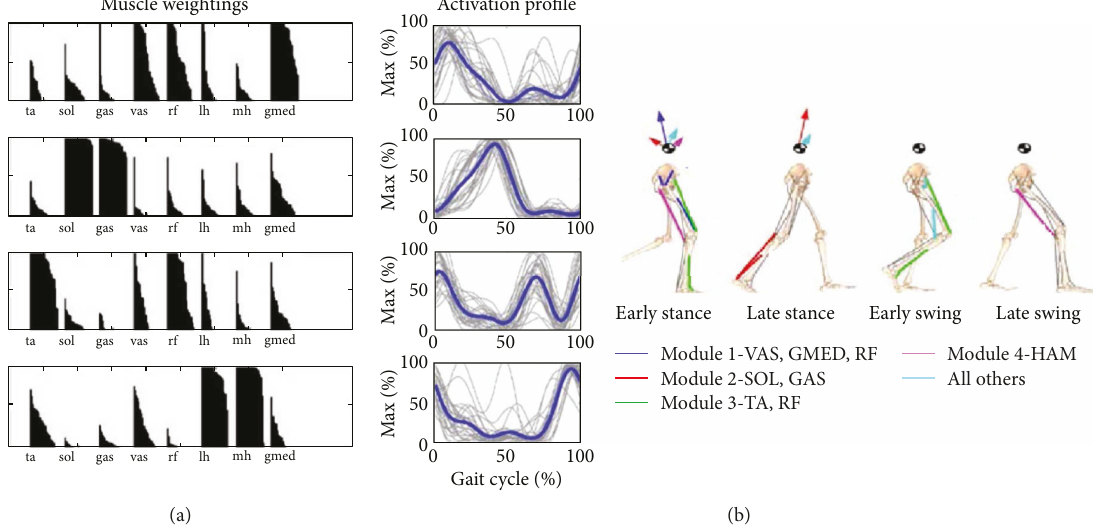
Figure 1: Image and caption modi fi ed from Clark et al. [14] and Neptune et al. [15]. (a) Muscle coactivation weightings from healthy individual walking at 1.2m/s determined from NNMF. (b) Activation pro fi les represent the timing of the module during the gait cycle. The thin lines were individuals from Clark et al. [14] with thicker lines representing the group average. Module contributions to walking are demonstrated on the skeleton rendition. Arrows are acting on the center of mass symbol to illustrate what the module contributions are to ground reaction forces for propulsion during walking. Module 1 can be seen to provide body support and decelerate forward motion. Module 2 contributes to body support as well but provides forward propulsion. Module 3 assists with limb clearance during swing phase and module 4 with limb deceleration. TA: tibialis anterior; SO: soleus; MG: medial gastrocnemius; VM: vastus